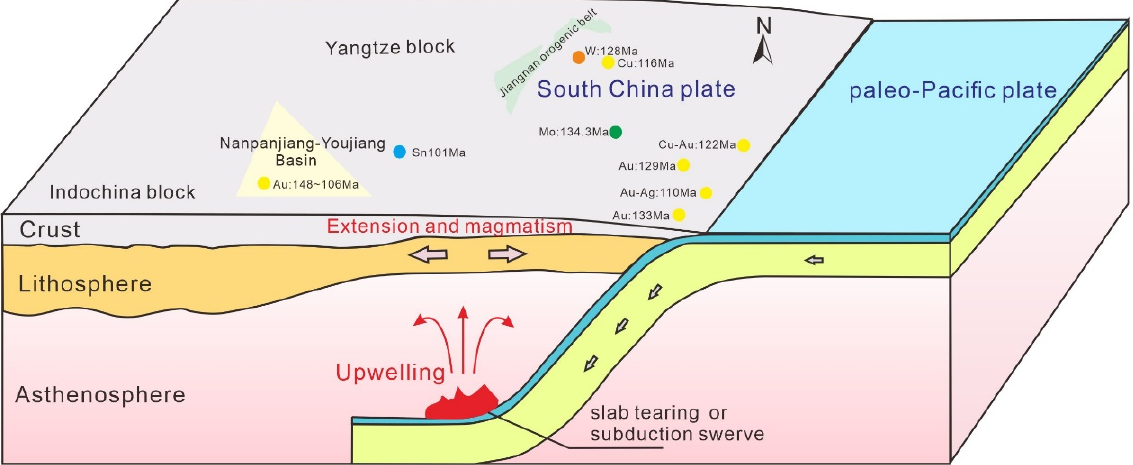
Figure 13. Simplified diagram of the metallogenic tectonic setting of the Early Cretaceous Carlin-type gold deposit in the Nanpanjiang-Youjiang Basin.